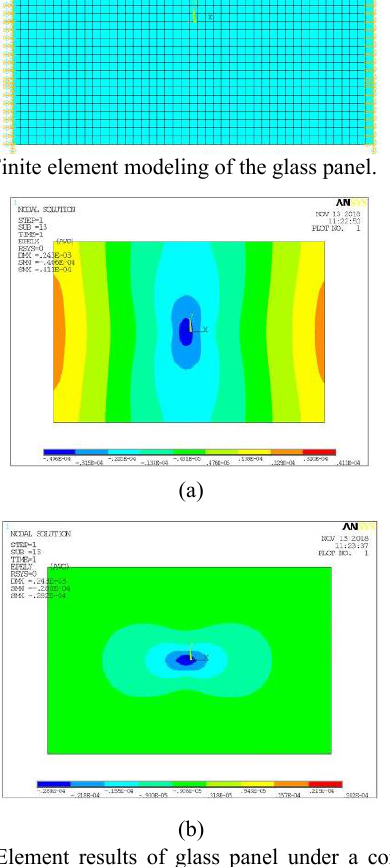
Fig. 6 Measured FBG’s wavelengths under different levels of load (a) change of FBG1’s wavelength, (b) change of FBG2’s wavelength, (c) change of FBG3’s wavelength, and (d) change of FBG4’s